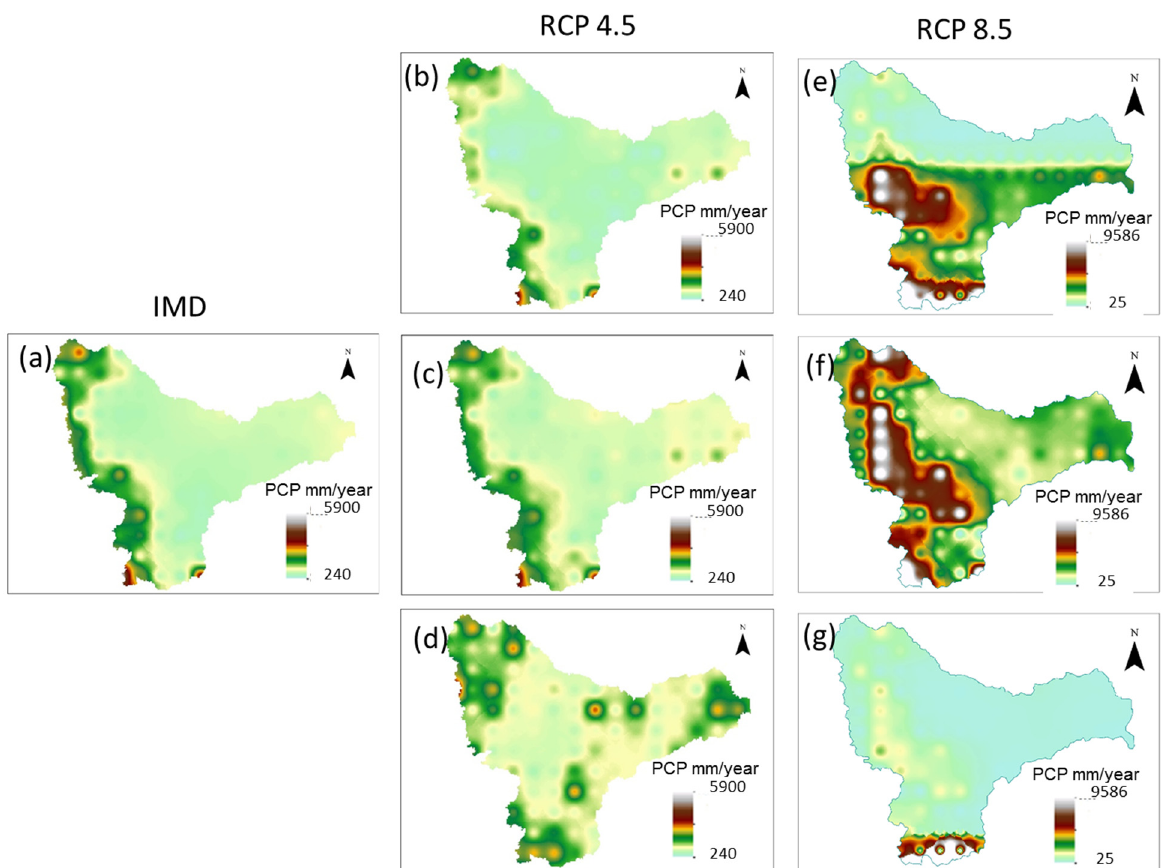
Figure 4. Annual average precipitation variation in the Krishna basin for ( a ) Historic, Future1 ( b , e ), Future2 ( c , f ), and Future3 ( d , g ) periods under RCP 4.5 and RCP 8.5